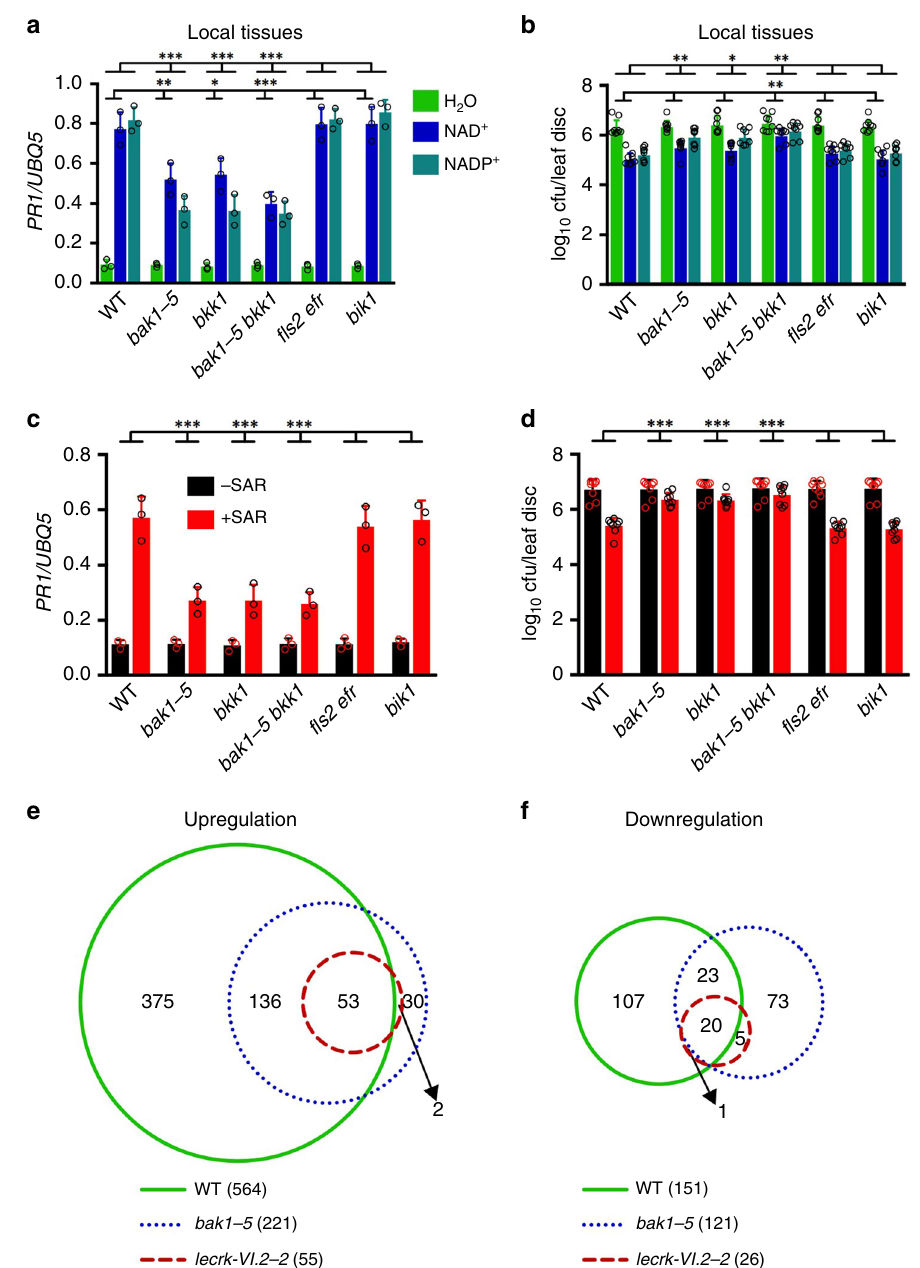
and GST-BAK1KD from a mixture of puri fi ed MBP-LecRK- VI.2KD and GST-BAK1KD, but only pulled down MBP from a mixture of puri fi ed MBP and GST-BAK1KD or MBP-LecRK- VI.2KD from a mixture of puri fi ed MBP-LecRK-VI.2KD and GST. This result indicates that LecRK-VI.2KD can